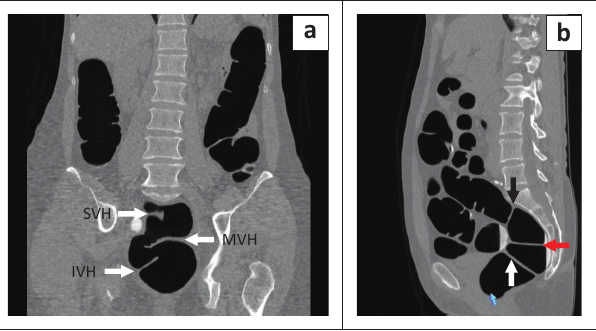
FIGURE 1: (a) 2D coronal view showing inferior, middle and superior valves of Houston. (b) 2D sagittal view showing the three valves of Houston in the rectum: superior (black arrow), middle (red arrow), inferior (white arrow).